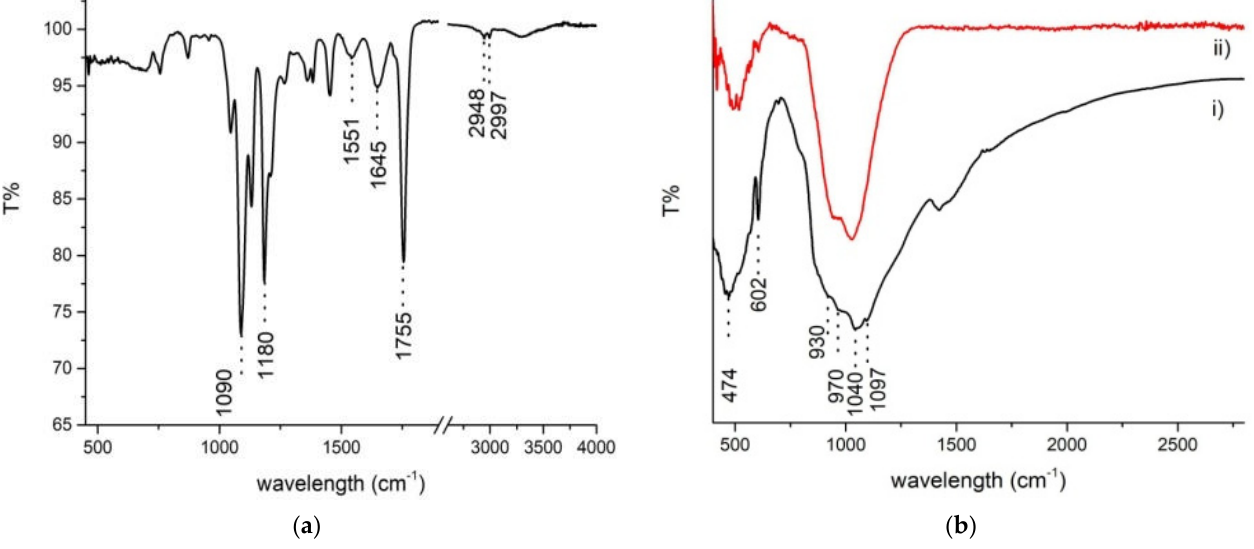
Figure 3. ( a ) FTIR spectra of (i) the Mn-BG target (black line), (ii) the Mn-BG film deposited on silicon substrate (red line); ( b ) ATR-FTIR spectrum of the polymeric